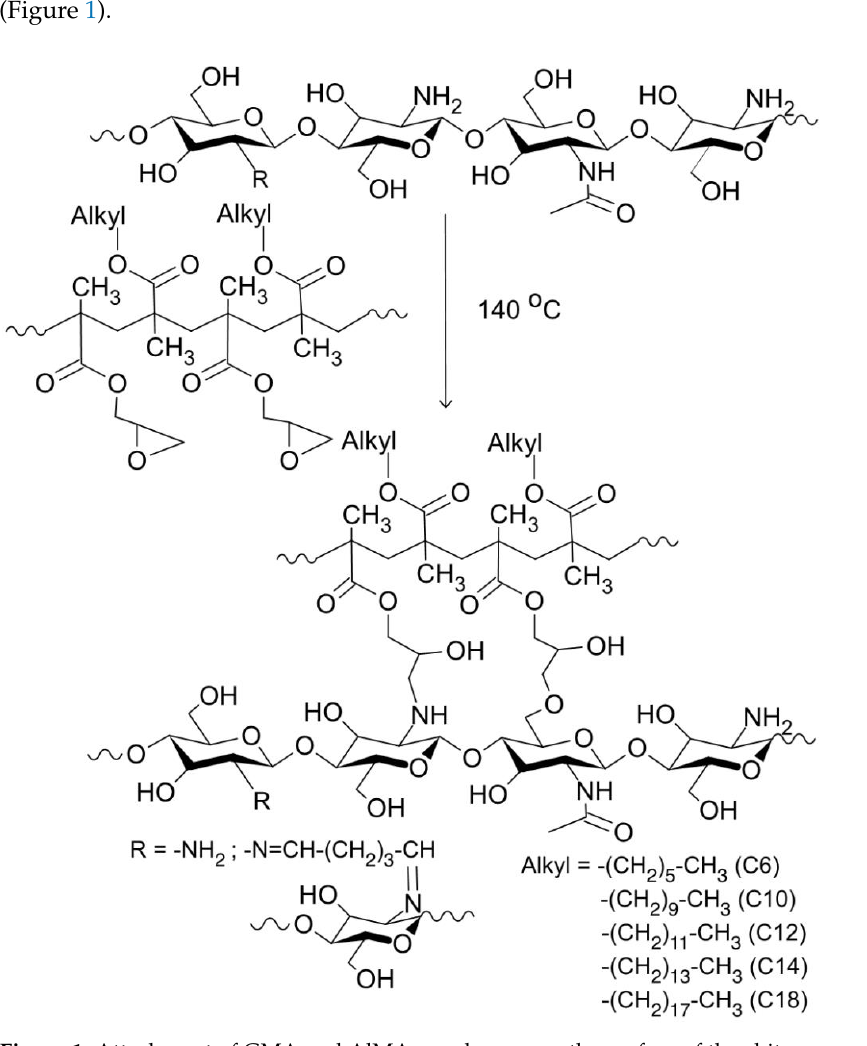
Figure 1. Attachment of GMA and AlMA copolymers on the surface of the chitosan aerogel.